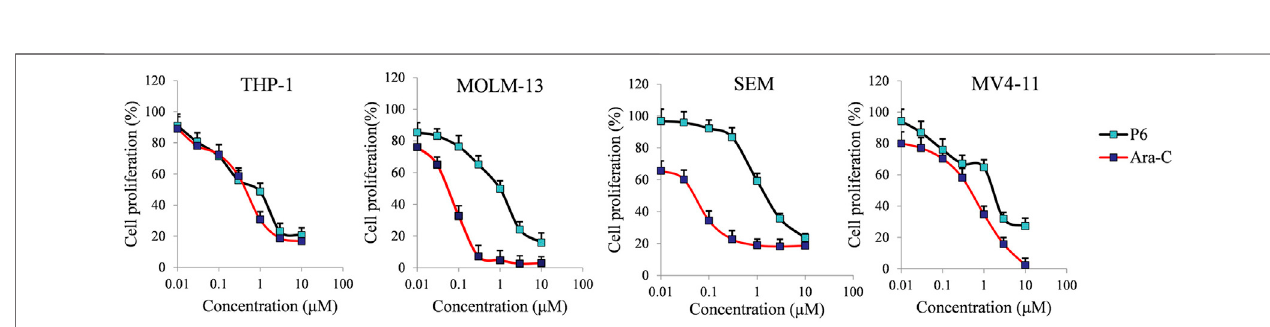
FIGURE 3 | The effect of molecule P6 in inhibition of MLLr cell proliferation. Cells were treated with different concentrations of P6 or Ara-C (0 – 10 µM) for 72 h and subjected to CCK-8 assay. Error bars represent the mean ± SD.